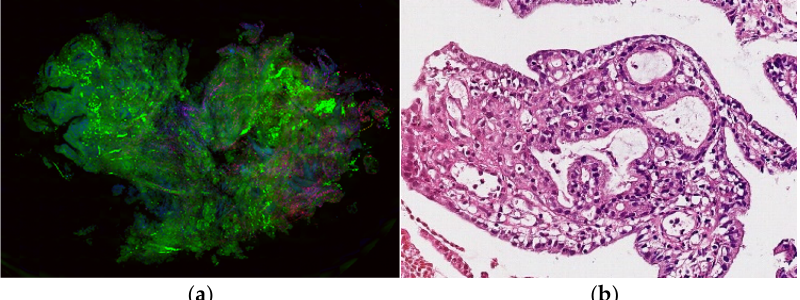
Figure 2. The example of a gastric cancer histopathology image. ( a ) SRS image. ( b ) H&E stained image.